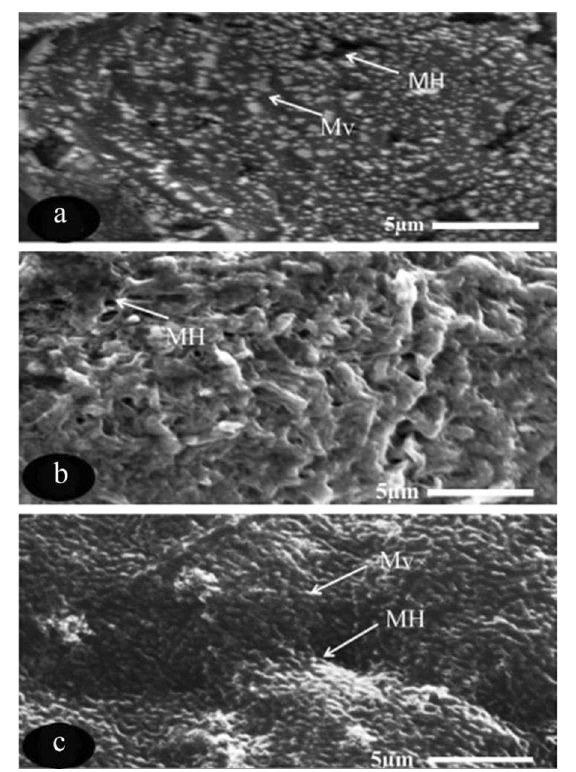
Fig. 4 SEM micrograph of the corneal epithelial cells of a Eudocimus albus b Anas platyryuncus; c Buteo buteo showing: Microholes (MH); Microvilli (Mv) (Scale bar, 5